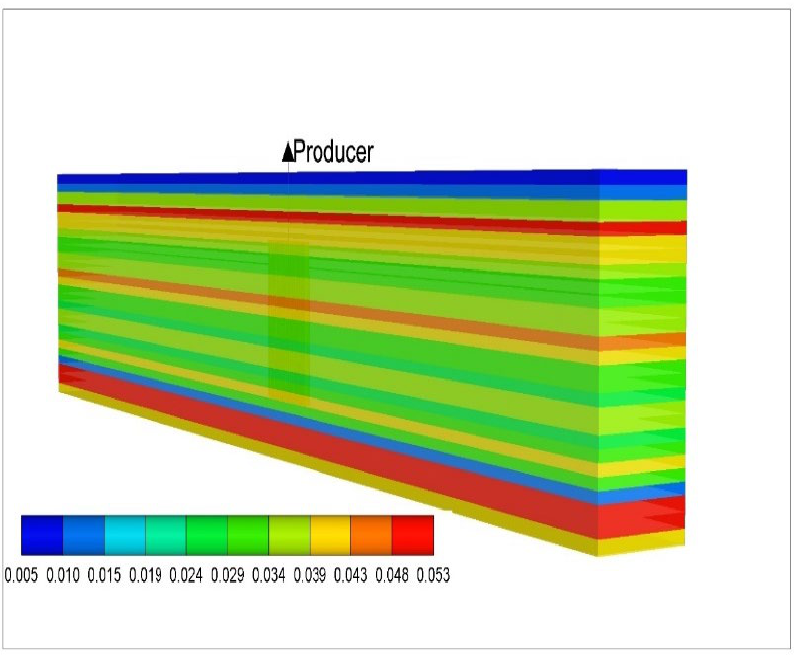
Figure 4. Three-dimensional view of the porosity model used in this study. The reservoir is divided into 26 horizontal layers, with original values of properties generated in the finer-grid geologic model averaged for each layer.